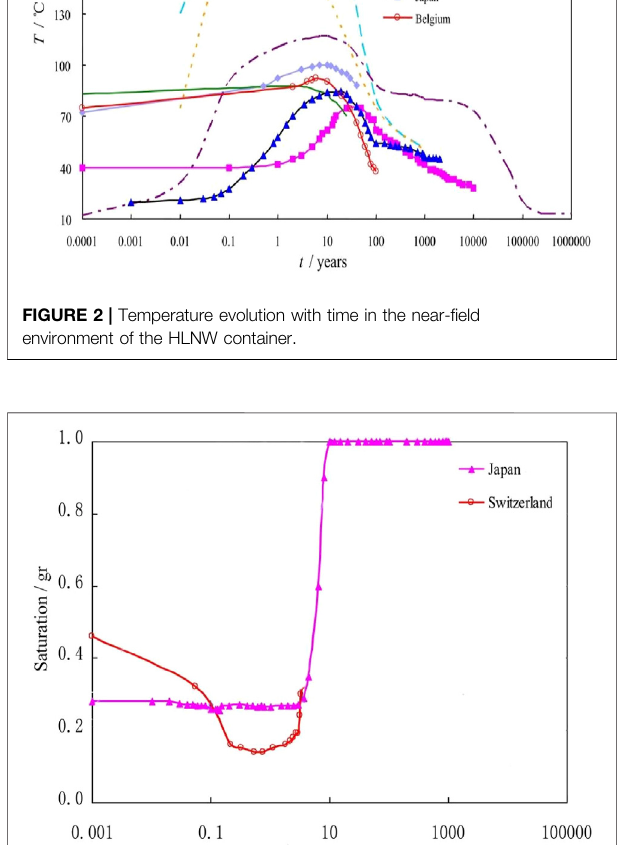
Frontiers in Materials |